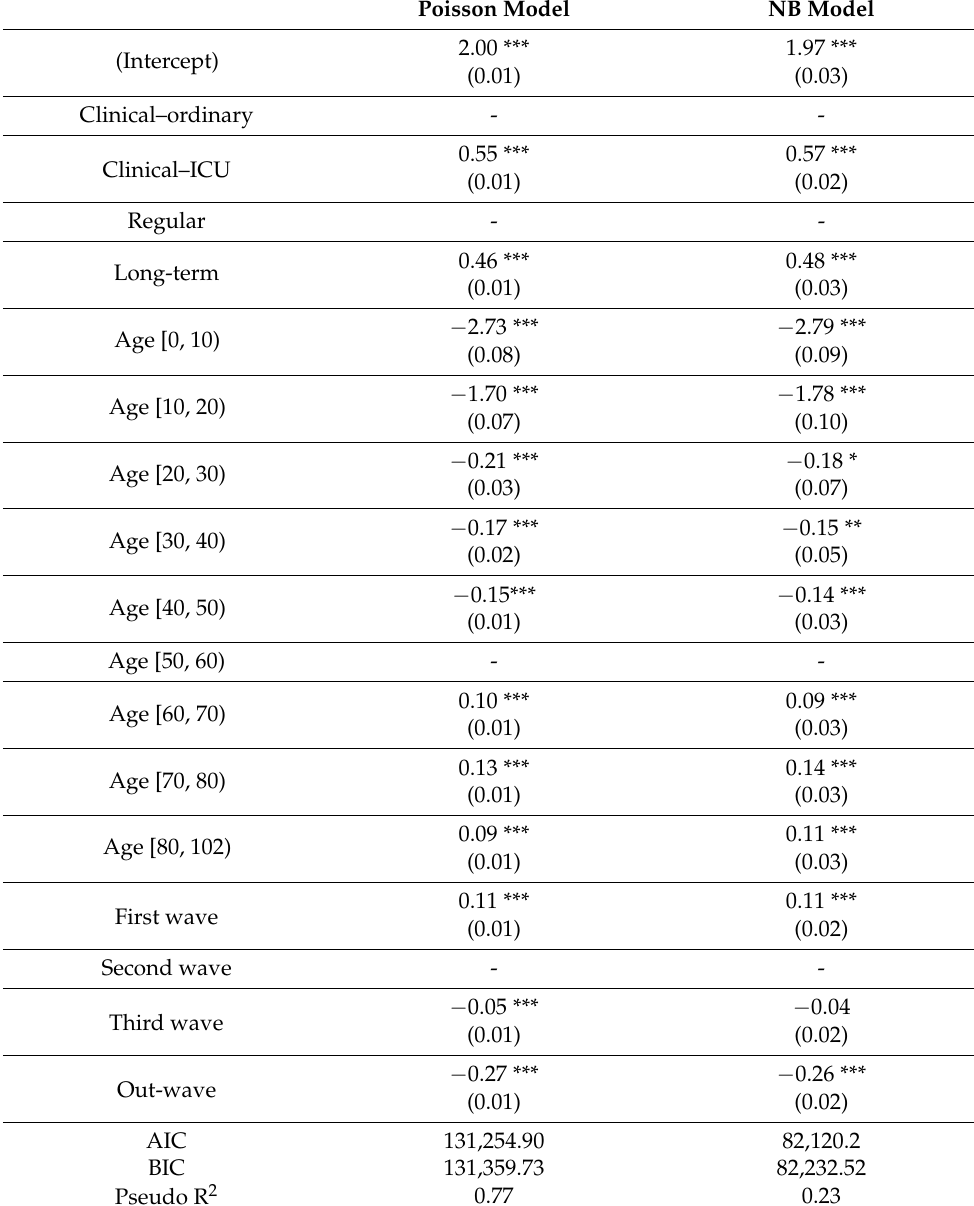
Table 2. Summary of estimates and standard errors (in brackets) of the Poisson and NB model regression